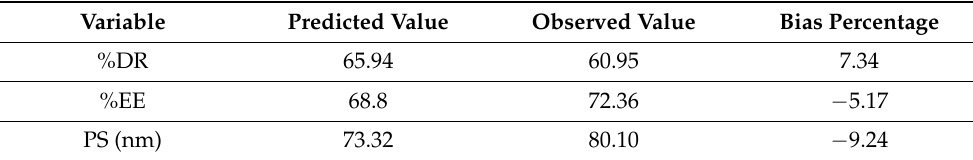
Table 2. Data of predicted and observed values for the HLPHNs.